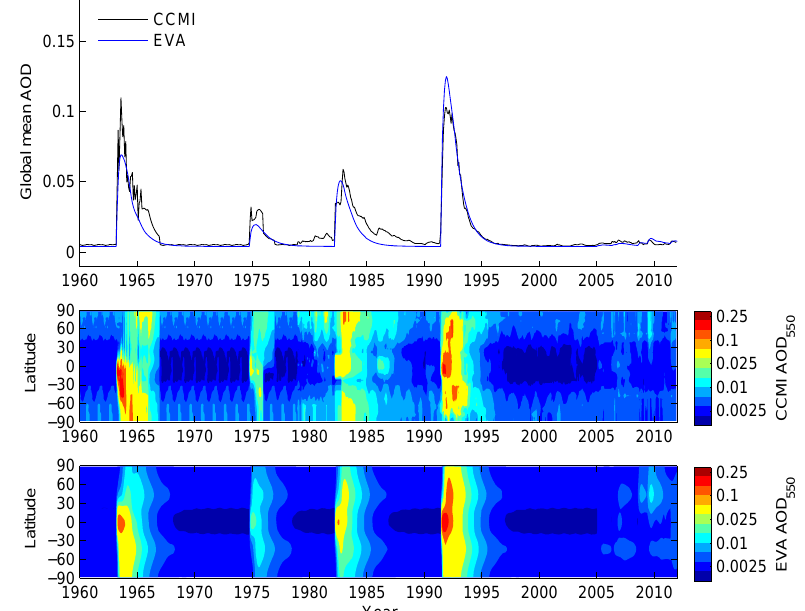
Figure 14. Aerosol optical depth over the period 1960–2015 from the CCMI data set and from EVA, using the volcanic eruption history of Table 1. Top: global mean AOD at 550nm from the two reconstructions. Bottom two panels: zonal mean AOD at 550nm as a function of latitude and time with log color